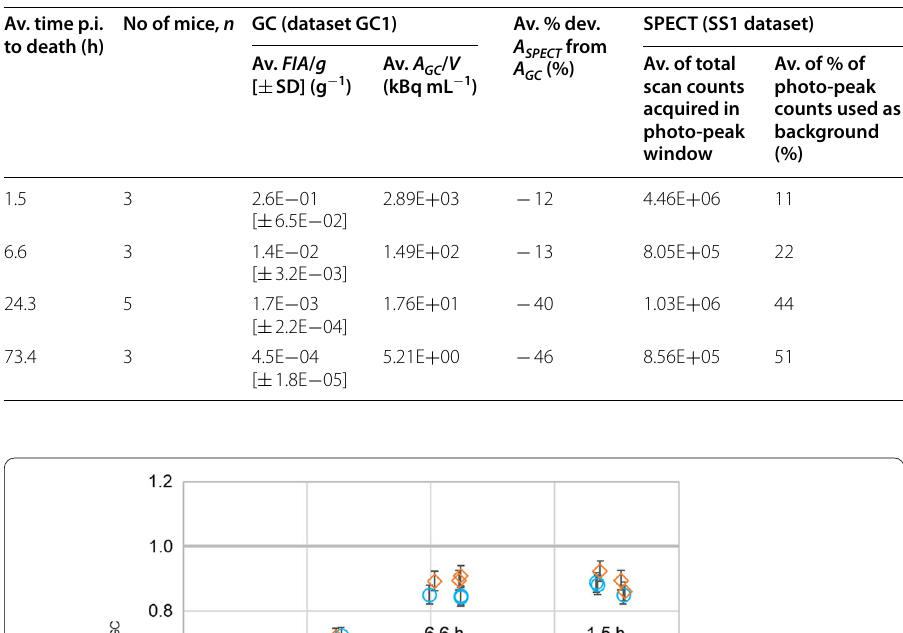
/ V and the percentage deviation GC